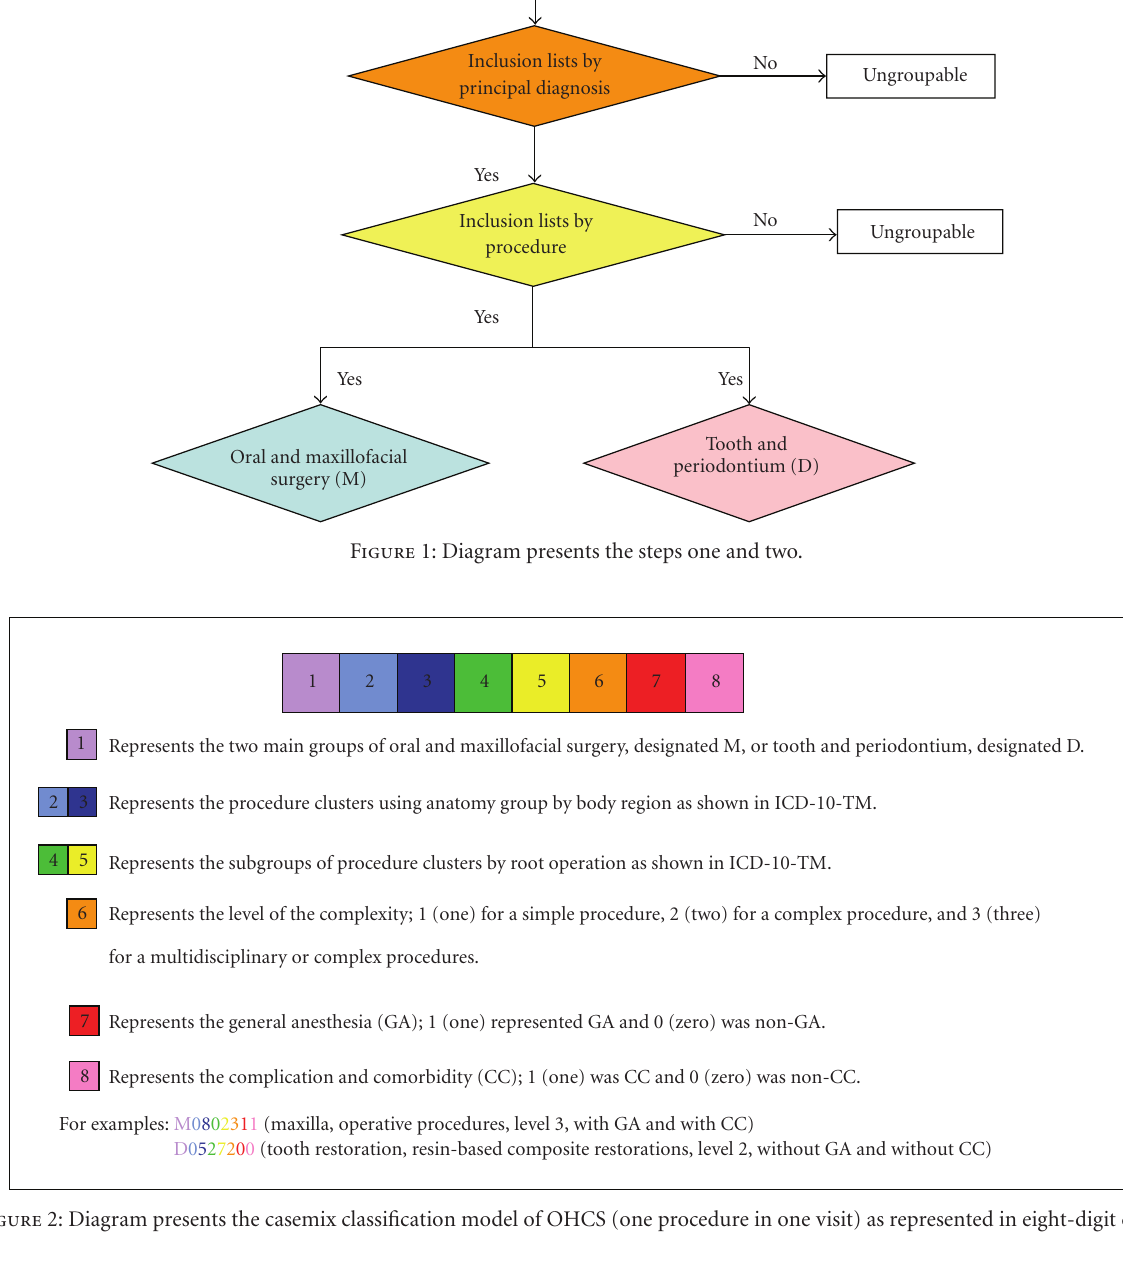
group, designated D. Multiple procedures in one visit were designated as P. The variables used for the OHCS grouping were included (1) PDx, (2) secondary diagnosis (SDx), (3) Proc (which were classified by the level of complexity by the same expert group), (4) anatomy group by body regions related to ICD-10-TM (Table 1), (5) root operation related to ICD-10-TM (Table 2), (6) general anesthesia (GA), and (7) complication and comorbidity (CC), using the